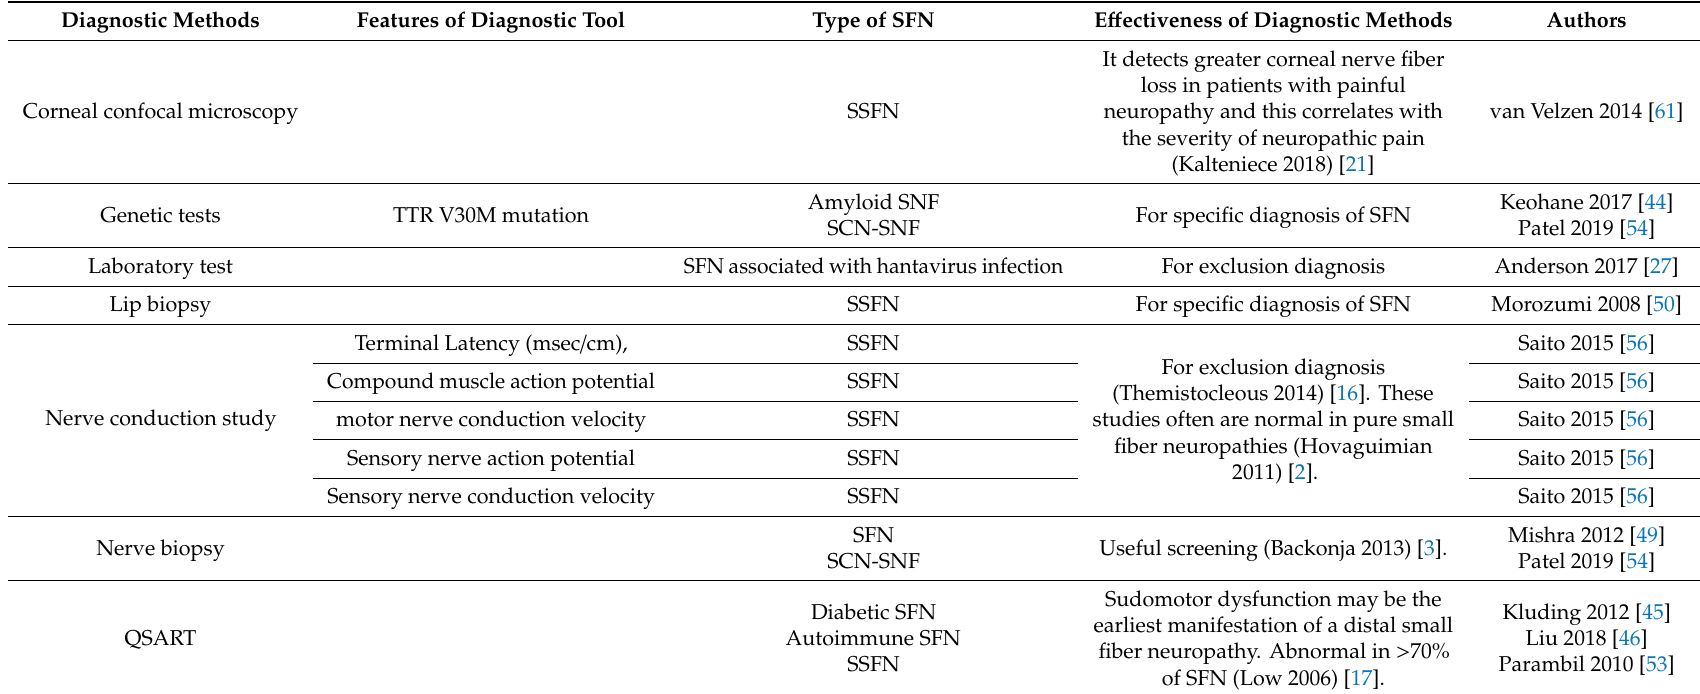
Table 2. Diagnostic methods for SFN, safety and e ff